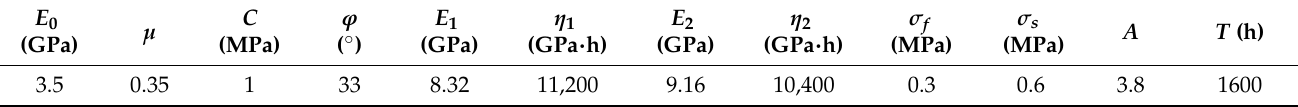
Table 2. Model parameters of the surrounding rock mass in section DL34+600